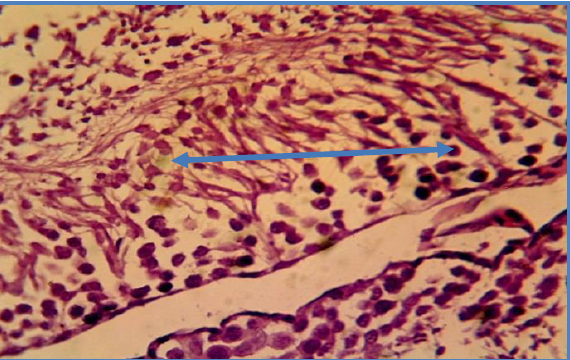
Figure, 5: Cross section of the rat testes of group T3 showing complete spermatogenesis (H and E stain 40x).